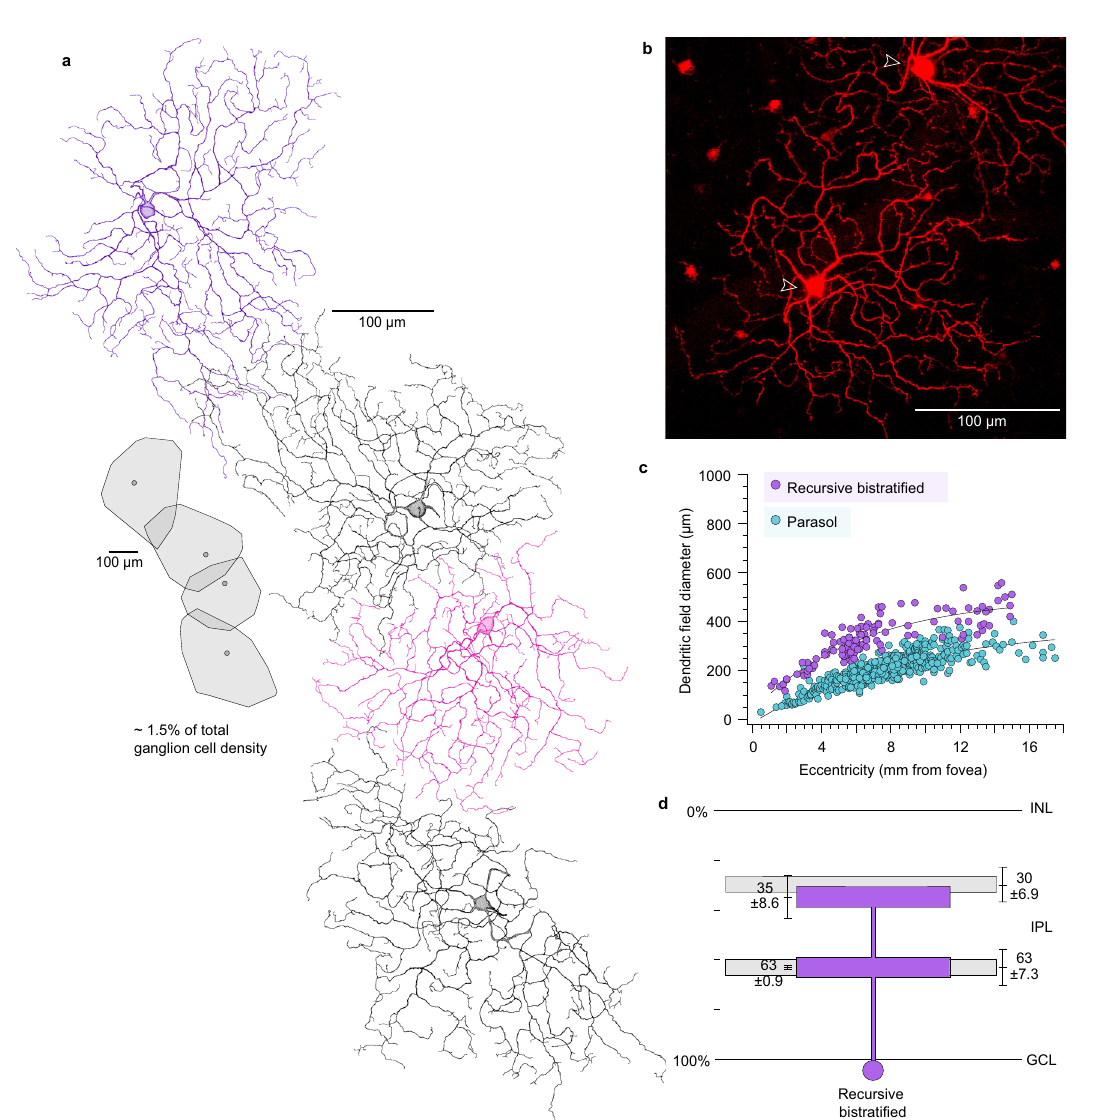
Fig. 2 Dendritic morphology and fi eld size, spatial density, and strati fi cation depth of recursive bistrati fi ed ganglion cells in the macaque monkey retina. Recursive bistrati fi ed cells comprise ~1.5% of total ganglion cells in the retinal periphery (dendritic fi eld coverage = 1.3; see Supplementary Fig. 1 for details) and were retrogradely labeled and photostained in vitro from injections of rhodamine dextran made into the Lateral Geniculate Nucleus (LGN) and Superior Colliculus (SC). a Camera Lucida tracings of four photostained cells at ~7 mm retinal eccentricity from tracer injections in the superior colliculus; inset, outlines around dendritic perimeters for each of the four cells indicates regular spacing and little dendritic fi eld overlap. b Photomicrograph of a recursive bistrati fi ed cell photostained in the in vitro retina after retrograde transport of rhodamine dextran permits precise targeting of this cell type for physiological study. c Dendritic fi eld diameter of low-density recursive bistrati fi ed ganglion cells (purple circles) plotted as a function of retinal eccentricity ( n = 122; mean ± s.d. = 327 ± 93; range = 117 – 557 µ m); is large relative to a sample of LGN-projecting parasol ganglion cells, shown for comparison (blue circles). d Strati fi cation depth of inner and outer recursive bistrati fi ed cell dendrites indicates costrati fi cation with the choline acetyltransferase immunolabeled strata ( n = 3; see also Supplementary Fig. 1f). Data are shown as mean ± s.d.; n number of